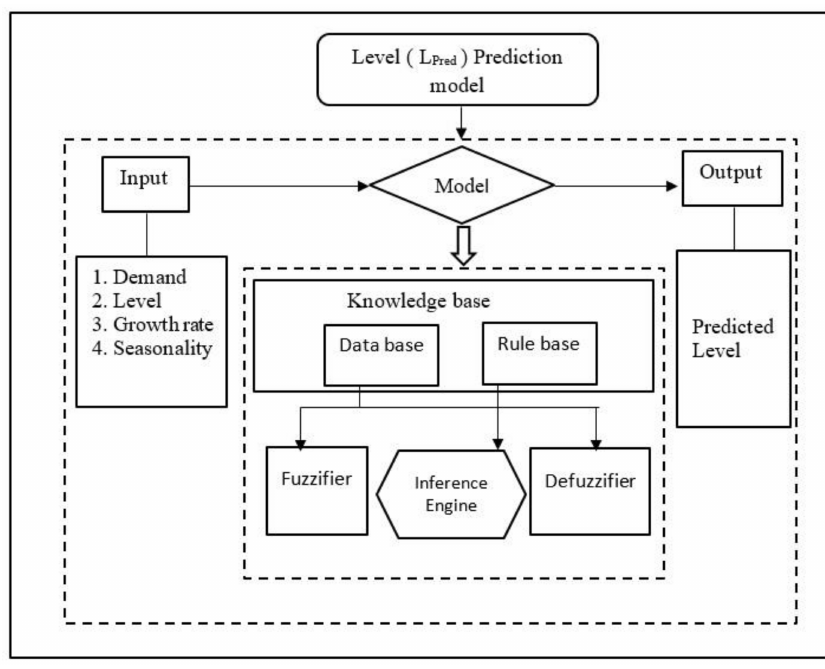
Figure 2. Structure of the level prediction model. Adapted from